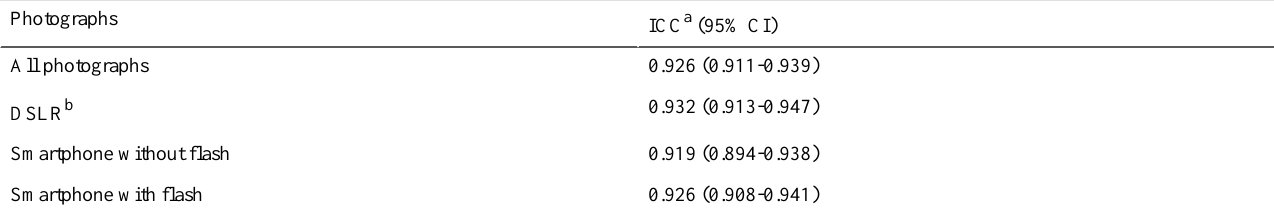
Table 1. Interrater agreement for the remote assessments done by 5 dermatologists for the intensity items of Scoring AD (iSCORAD) for different camera